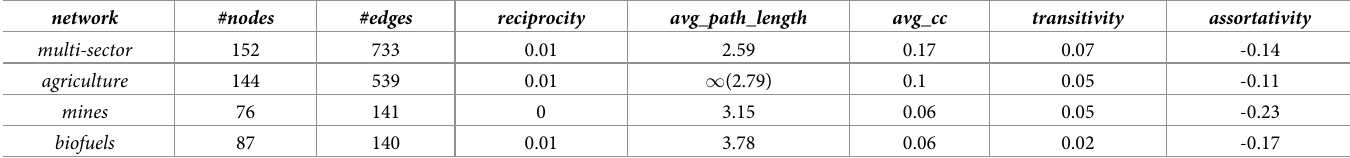
Table 2. Structural characteristics of the land trade networks. All measures refer to the directed version of the graph, except for avg_cc and avg_path_length which are computed on the undirected graph. Note that the latter is not available for the agriculture network since it is not weakly connected (value associated to the largest connected component is reported in